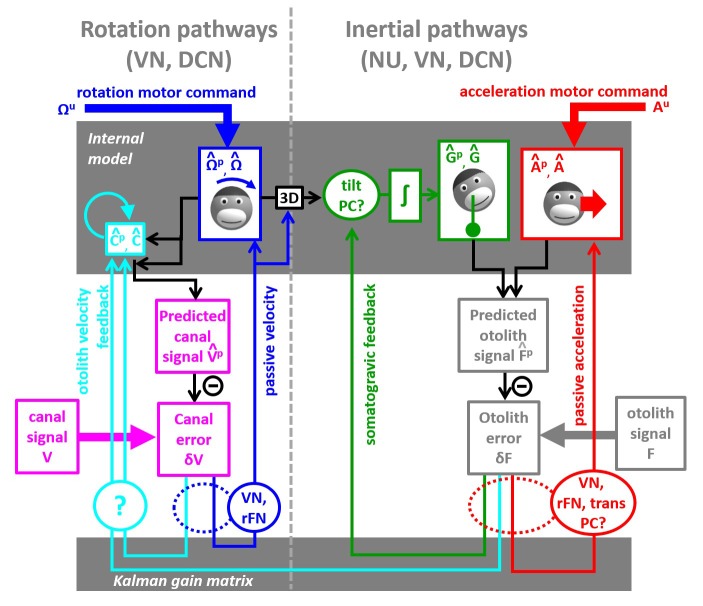
Alternative diagram.Where the Kalman feedback encoding passive tilt velocity is removed. Instead, a final rotation estimate Ω^ is computed and transformed into a tilt velocity signal.